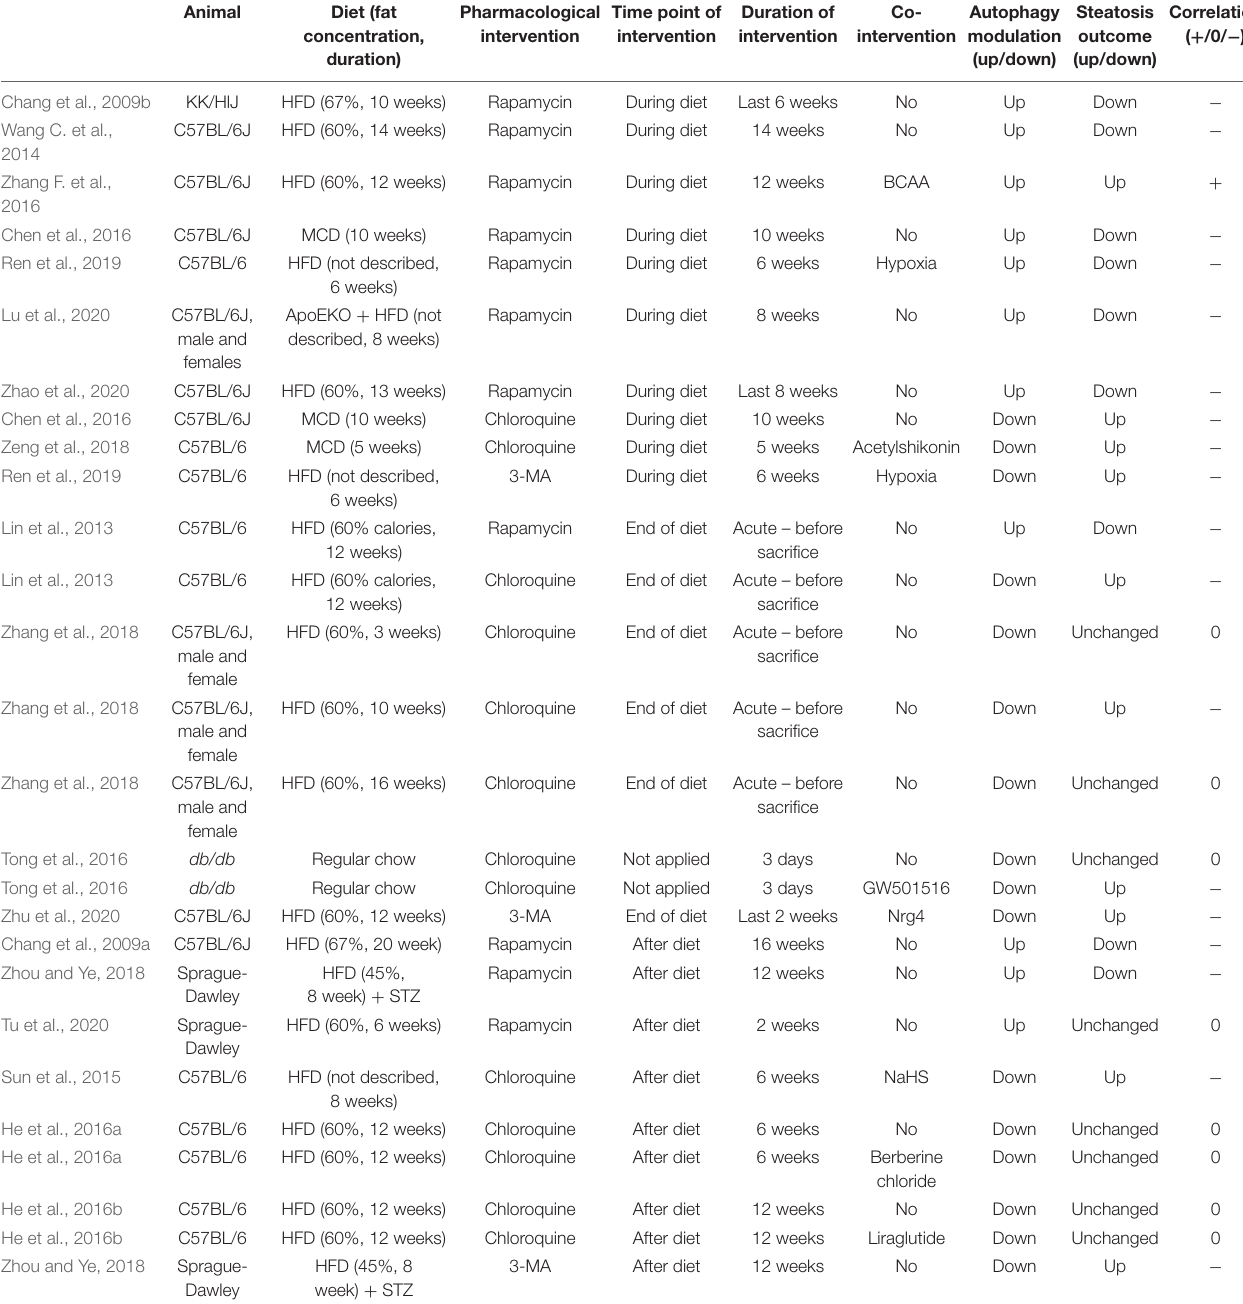
TABLE 4 | Pharmacological intervention on autophagy. Animal Diet (fat